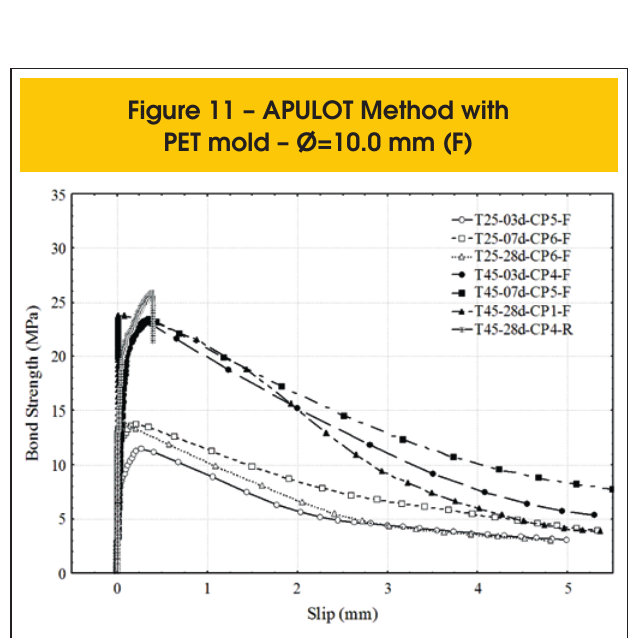
Figure 9 – APULOT Method with PET mold – Ø=8.0 mm